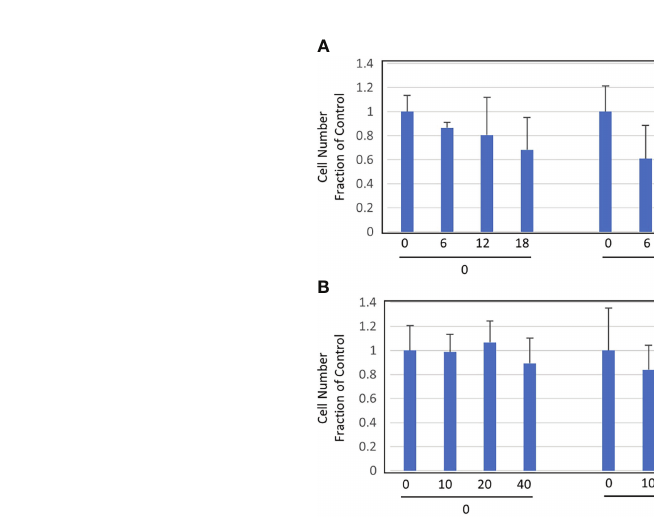
FIGURE 2 | Cell survival assay. (A) Cell survival assay performed in triplicate showing the number of surviving cells (left) two days after inoculation with 0, 6, 12, 18 µL of HPV16 PsVs (5.7 × 10 6 IU/mL) and (right) one day after treatment with 20 µg/mL ganciclovir, which was performed one day after inoculation with 0, 6, 12, 18 µL of HPV16 PsV into 293FT cells. (B) Cell survival assay performed in triplicate showing the number of surviving cells (left) two days after treatment with 0, 10, 20, 40 µg/mL ganciclovir and (right) one day after treatment with 0, 10, 20, 40 µg/mL ganciclovir, which was performed one day after inoculation with 12 µL of HPV16 PsV (5.7 x 10 6 IU/mL) into 293FT